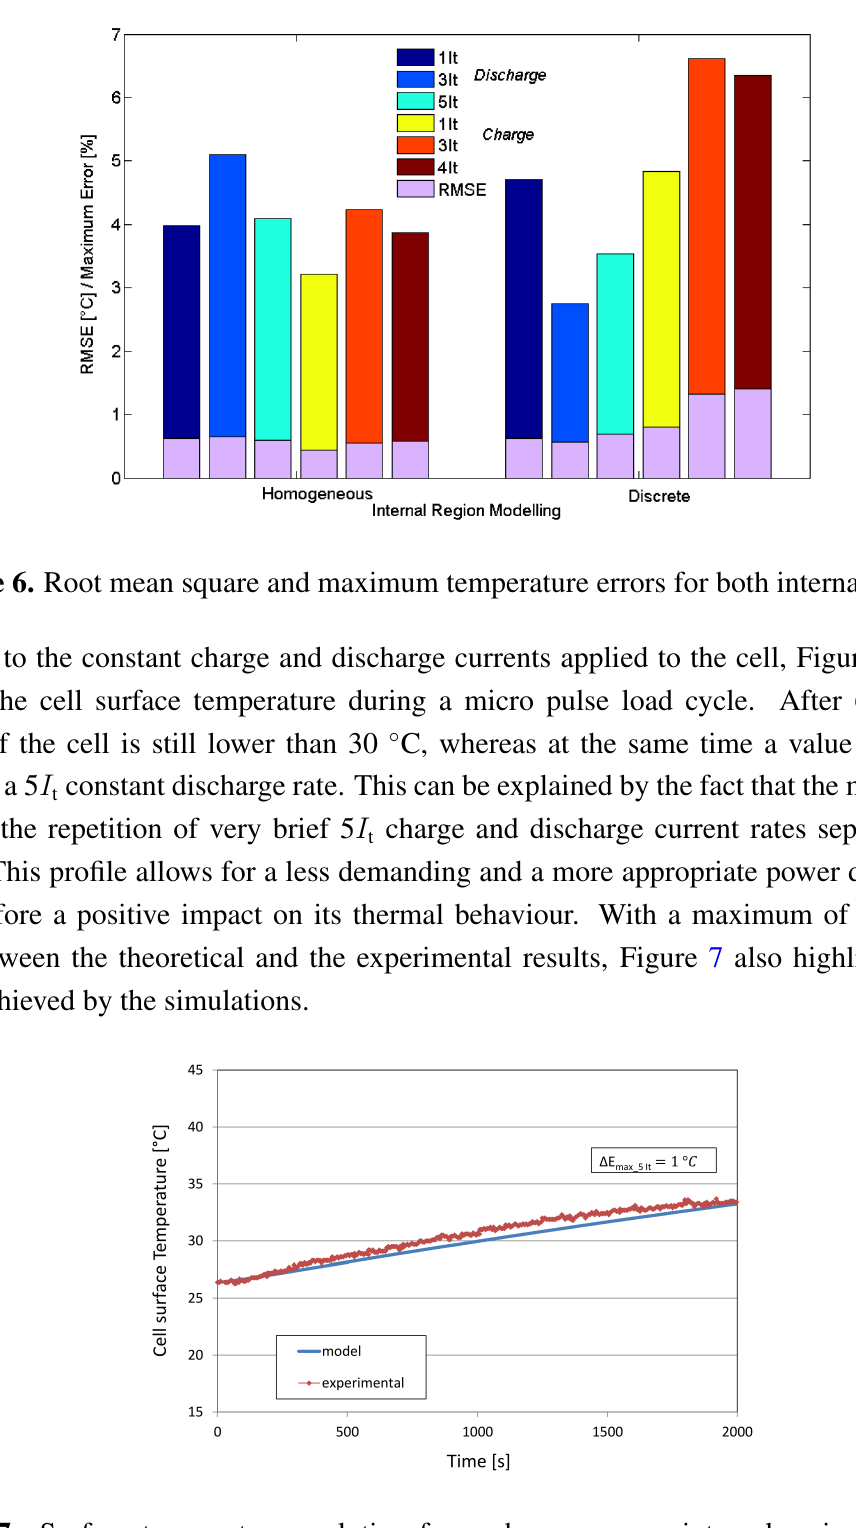
Figure 7. Surface temperature evolution for an homogeneous internal region of the cell during a 5 I micro pulse t